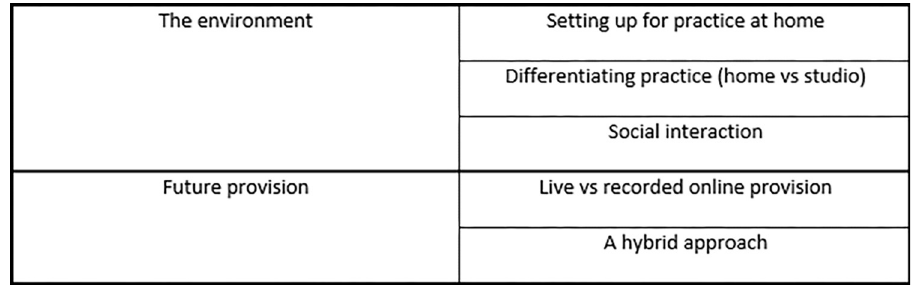
Fig 2. Themes and